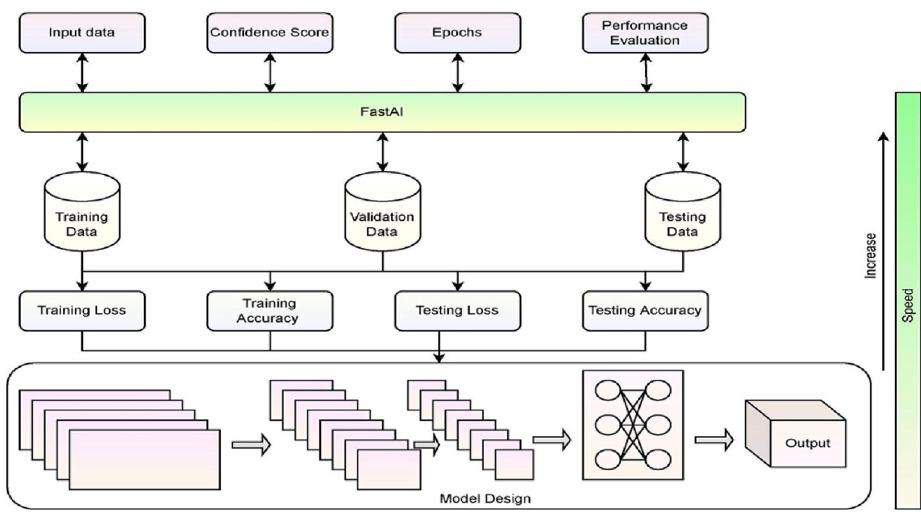
Figure 2. FastAI framework for deep learning